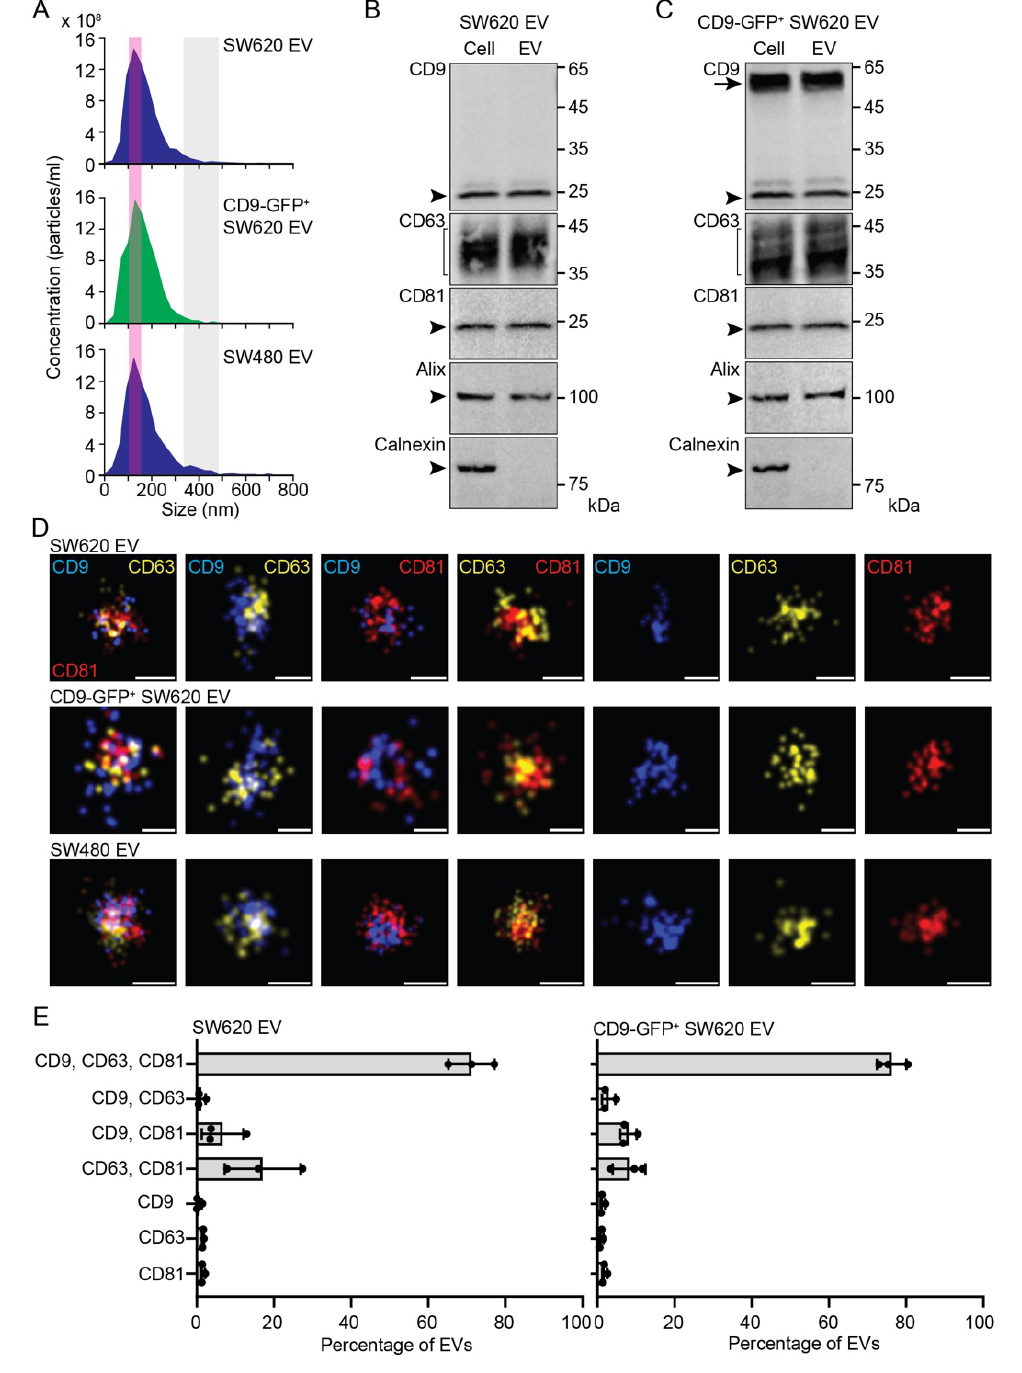
Figure 2. Characterization of EVs released by SW620, CD9-GFP + SW620, and SW480 cells. ( A – E ) EVs were recovered from the conditioned media of SW620, CD9-GFP + SW620, and SW480 cells by dif- ferential centrifugation, and the resulting 200,000 × g pellets were analyzed by the ZetaView particle analyzer ( A ), immunoblotting ( B , C ), and dSTORM ( D , E ). The concentration and size of EVs derived from the indicated cells are shown ( A ). Note the presence of a common population of small particles (<200 nm) with a peak at 100–150 nm (pink area), and larger ones (350–500 nm, gray areas) enriched in SW480 samples. EVs, and for comparison the cells from which they were derived, were probed by immunoblotting for CD9, CD63, CD81, Alix, and Calnexin ( B , C ). Arrowheads and brackets indicate the endogenous proteins of interest, while the arrow points to the CD9-GFP fusion protein. Molecular mass markers (kDa) are indicated. EVs were imaged after immunolabeling of three tet- raspanins using dSTORM ( D ). The proteins of interest (CD9, CD63, and CD81) were pseudo-colored